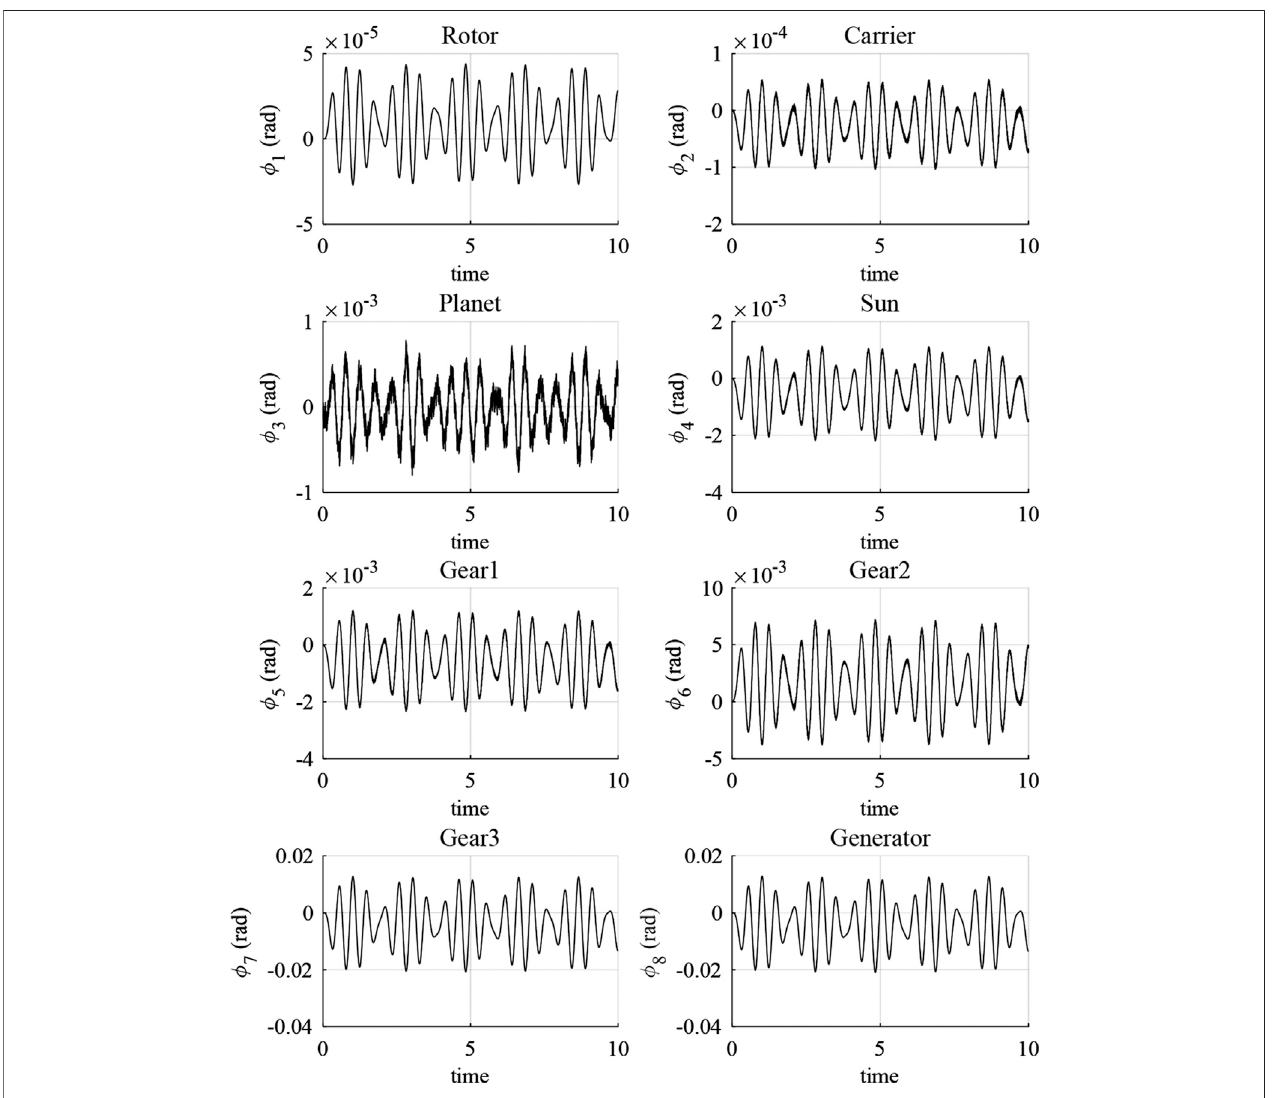
FIGURE 6 | Angular displacement difference between the torsional model and the 3D